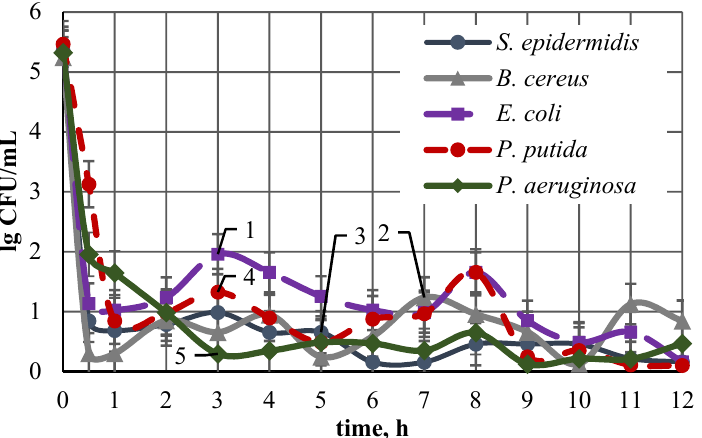
Figure 5. E. coli (curve 1), B. cereus (curve 2), S. epidermidis (curve 3), P. putida (curve 4), P. aeruginosa (curve 5) growth inhibition in presence of Sample 5-TiO 2 /Ag 23.1 at.% /Cu 21.6 at.% .